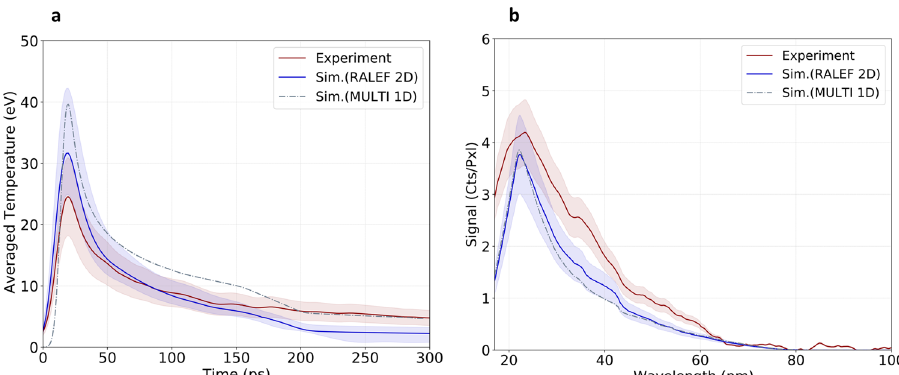
Fig. 4 WDM Characterization. a Streaked Optical Pyrometry (SOP) measurement. Temperature evolution as a function of time (red curve) averaged within the 50 μ m diameter proton probing area compared with the temperatures extracted from the 2D RALEF2D (blue curve) and the 1D MULTI-fs (dashed grey curve) hydrodynamic codes, determined at the critical density for a 532 nm wavelength. b X-ray pinhole grating camera (XPHG) measurement. Experimental time-integrated X-ray emission (red curve) compared with the prediction obtained with the PrismSPECT code by post- processing the hydrodynamic pro fi les obtained with the RALEF2D (blue curve) and MULTI-fs (dashed grey curve) hydrodynamic codes. The simulation curves are convoluted with the respective resolutions of 10 ps for the SOP diagnostic and 15 nm for the